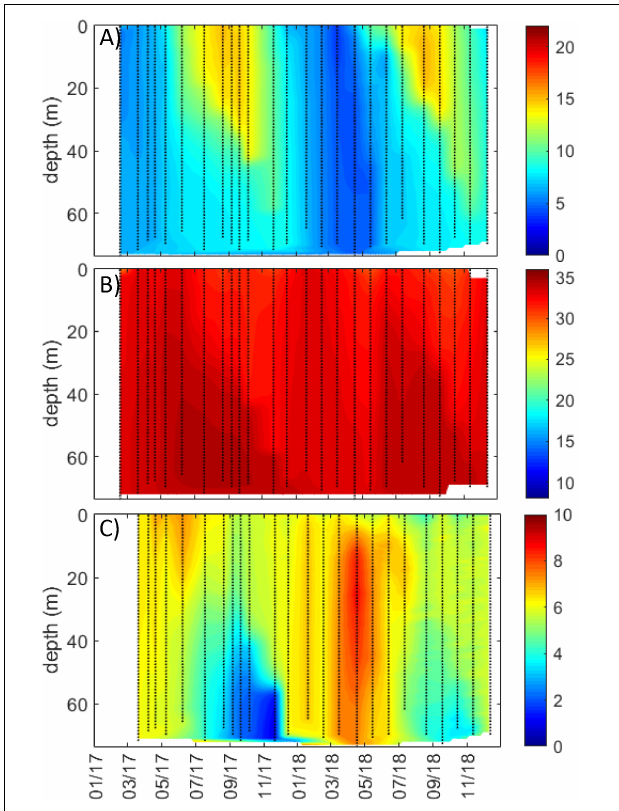
FIGURE 6 | Full water column profiles (from 0 m to near bottom) for coastal station Skinnbrokleia in study region Runde/western Norway for (A) temperature ( ◦ C), (B) salinity, and (C) oxygen (mL L − 1 ). Data are interpolated, with black symbols showing location of